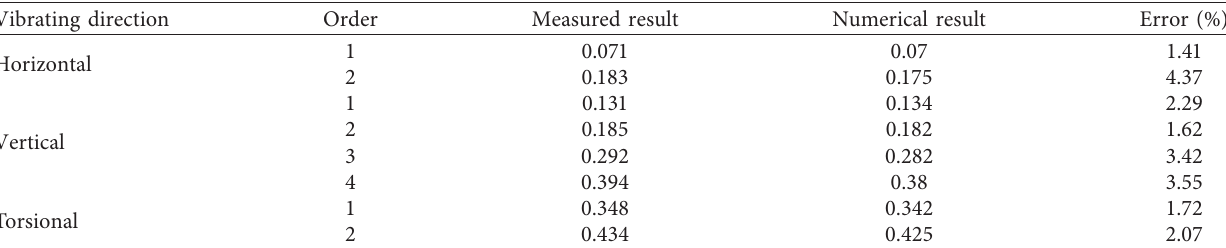
Table 2: Comparison of the bridge frequencies.